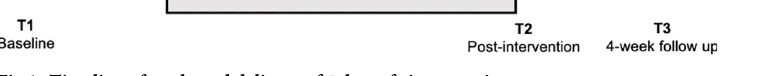
Fig 1. Timeline of study and delivery of #chatsafe